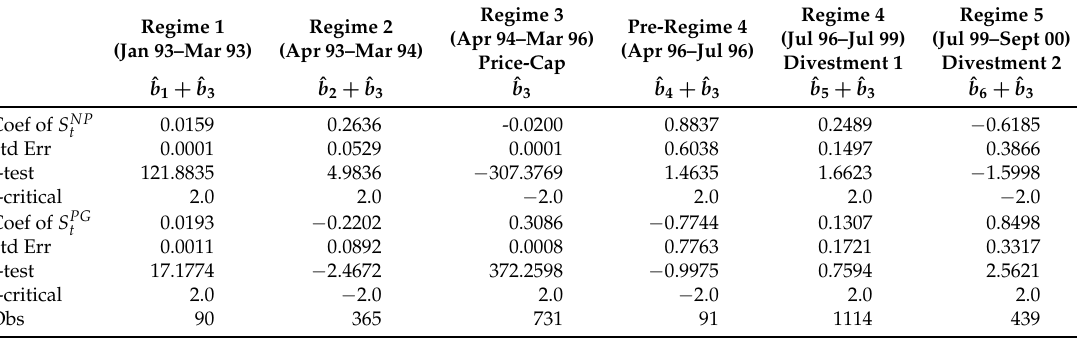
Table 9. The effect of market share of NP and PG on SMP across different